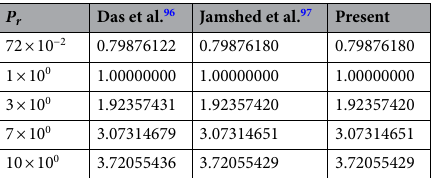
Table 5. Comparison regarding the values of 0 , S 0 , N 0 and B (cid:31) r = = =